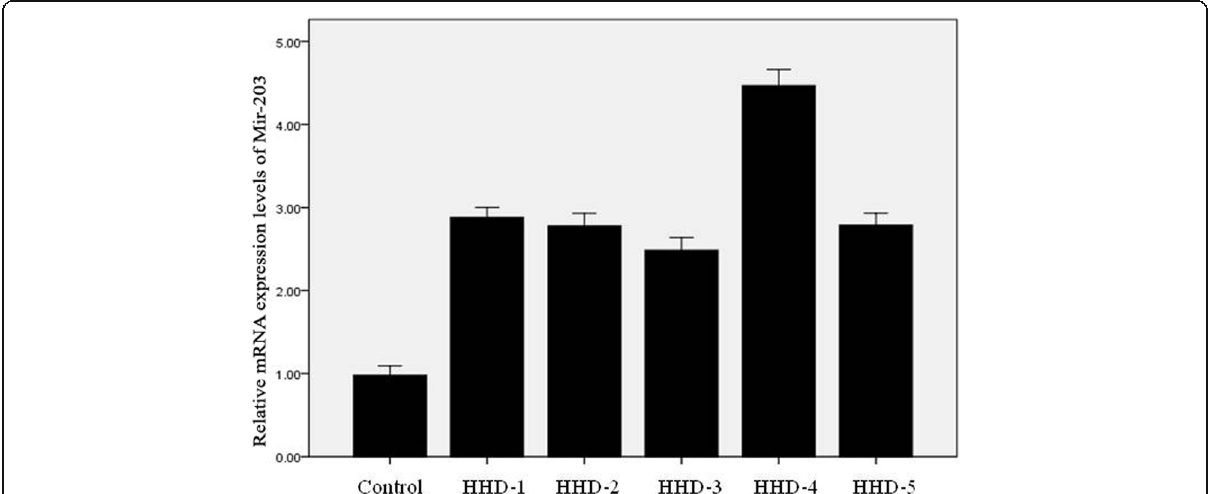
Fig. 8 MiR-203 expression in HHD patients. Real-time PCR was performed to examine the mRNA expression levels of miR-203 in HHD